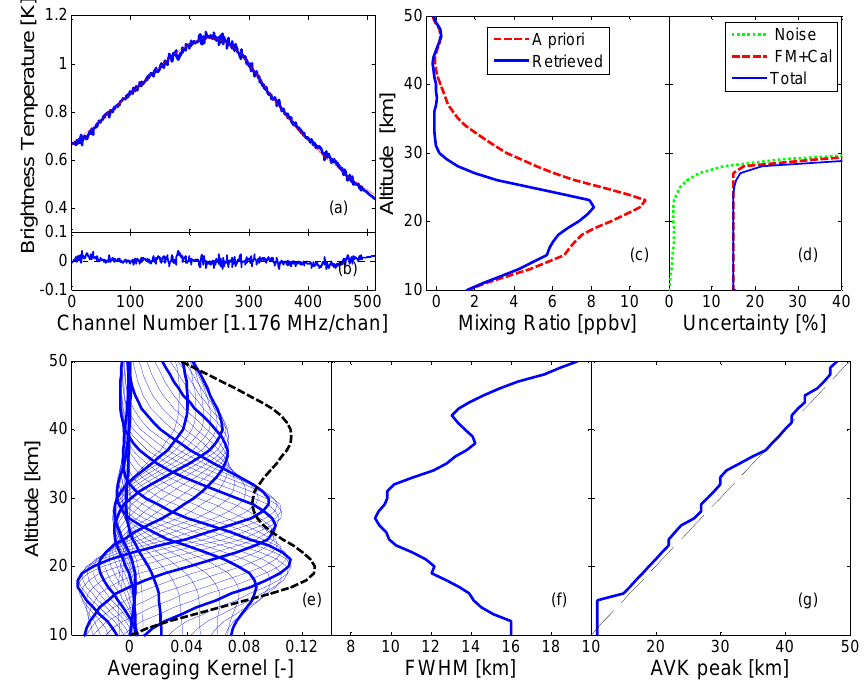
Figure 2. As in Figure 1, but for GBMS HNO 3 retrievals. The 600 MHz spectral pass band 2 Fig. 2. As in Fig. 1, but for GBMS HNO 3 retrievals. The 600MHz spectral pass band where the HNO 3 lines are located ranges from 268.911 to where the HNO 3 lines are located ranges from 268.911 to 269.511 GHz. 3